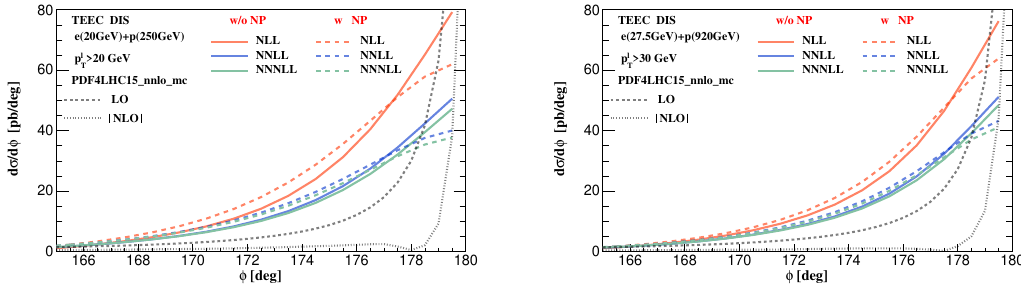
Figure 4 . Nonperturbative effects for NLL (orange), NNLL (blue) and N 3 LL (green) TEEC dis- tributions in DIS. The solid and dashed lines are the predictions without and with nonperturbative effects, respectively.